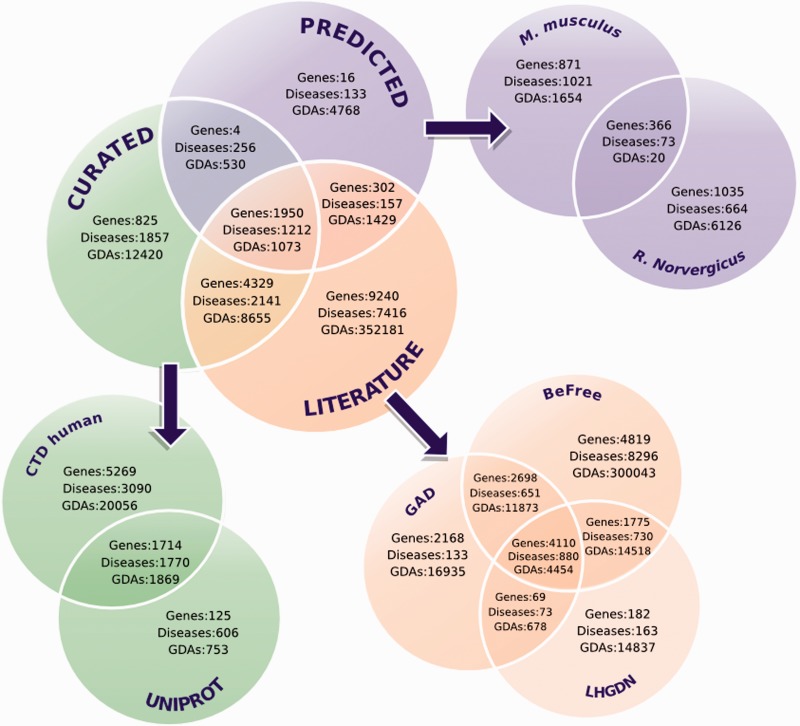
Venn diagrams showing the overlaps among genes, diseases and GDAs according to their source. LITERATURE corresponds to GAD, BeFree and LHGDN.